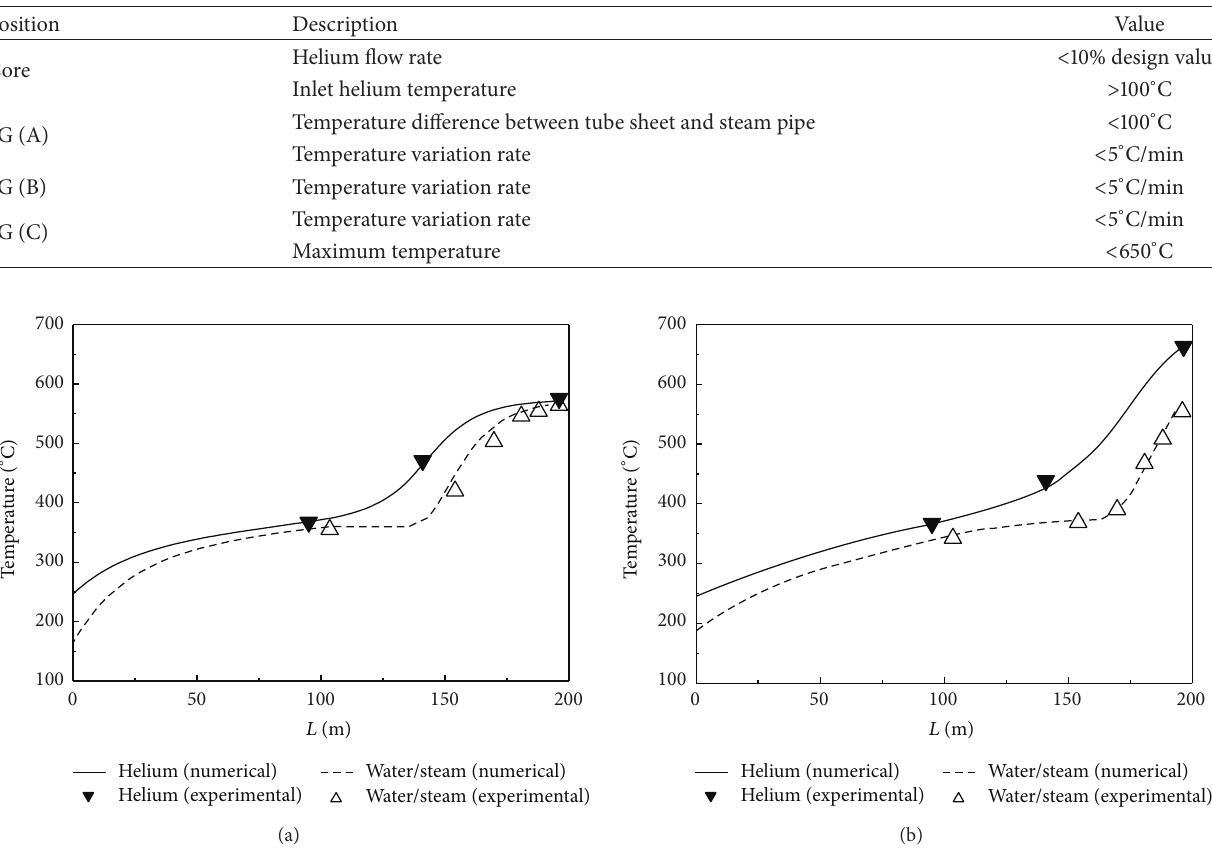
Table 2: Criterion for ARHRP.